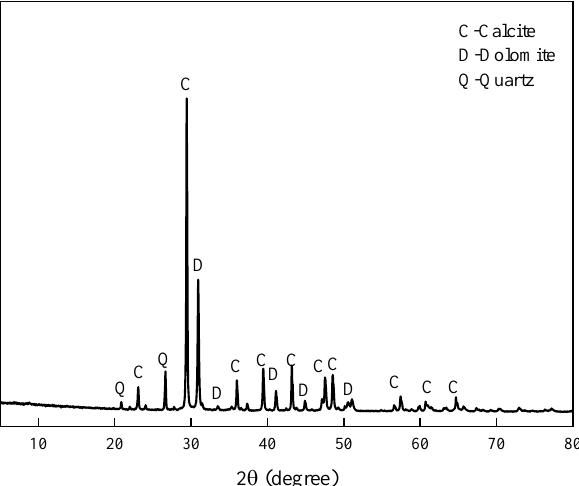
Figure 2. XRD patterns of dolomitic limestone S1# from Baofuling, Shandong, China.